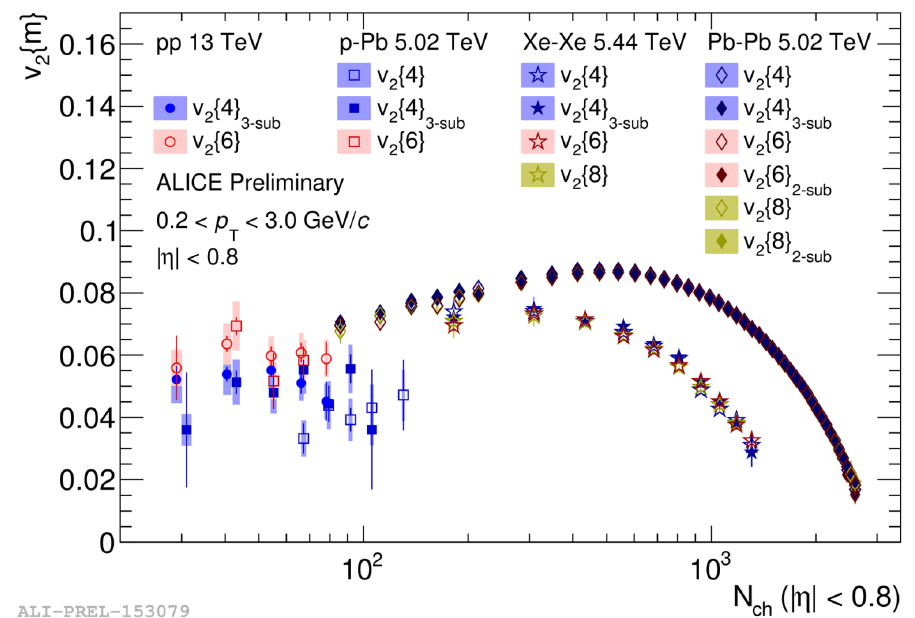
Figure 9. Multiplicity dependence of v 2 { 4 } , v 2 { 6 } and v 2 { 8 } in 13 TeV pp, 5.02 TeV p–Pb, 5.44 TeV Xe–Xe and 5.02 TeV Pb–Pb